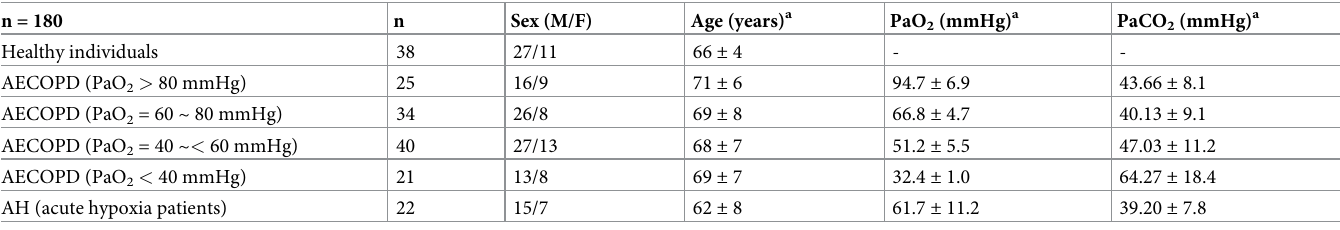
Table 1. Clinical characteristics of study